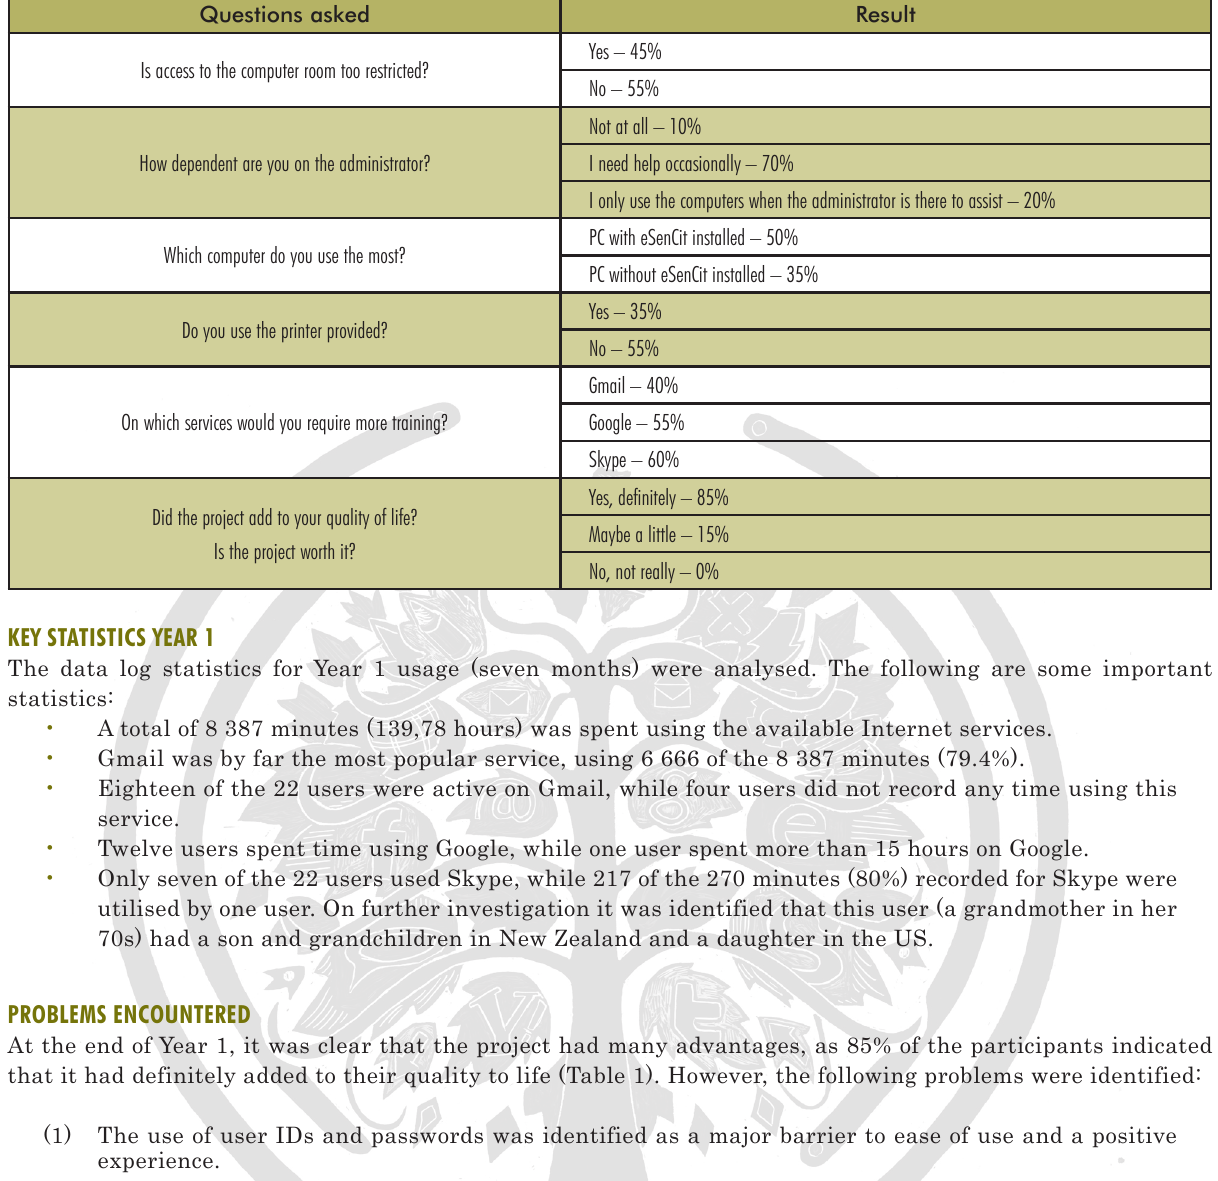
SENIOR CITIZENS’